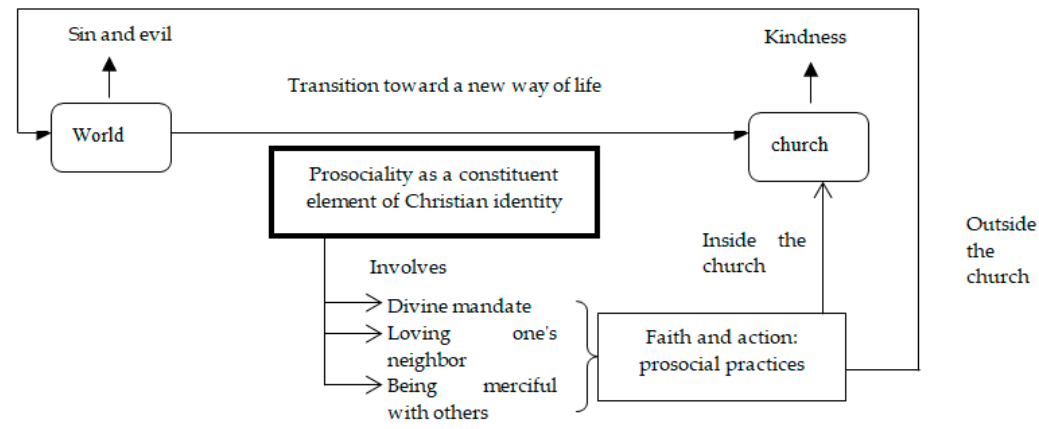
Figure 2. Axial coding: subjective meaning of prosociality.